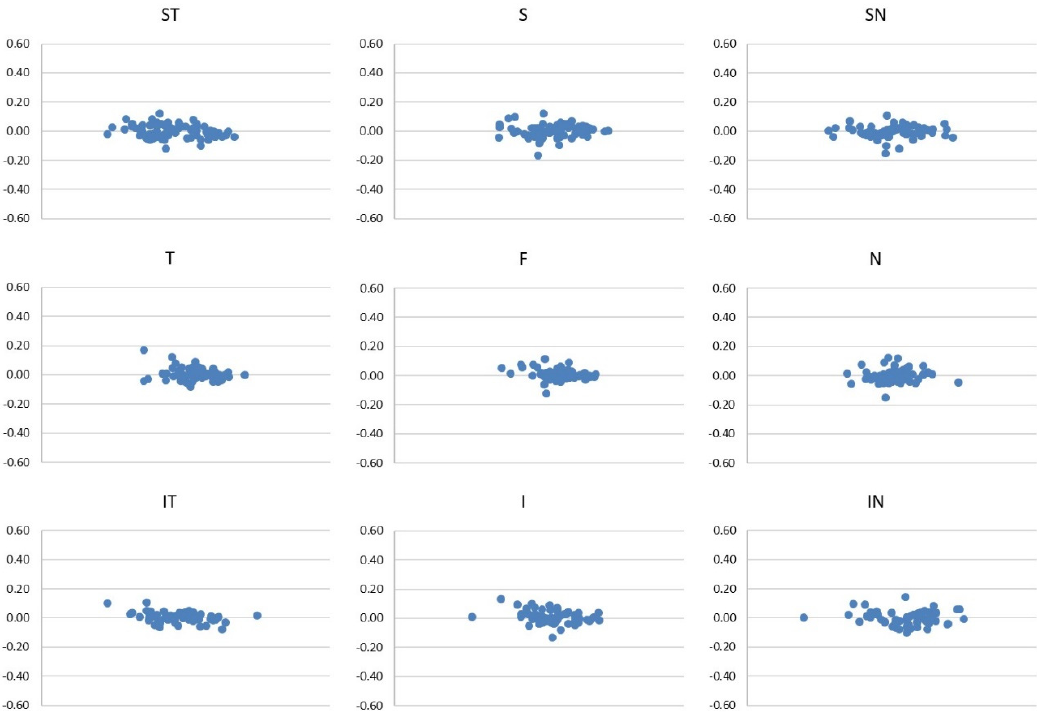
Figure 4. Bland–Altman plots of the first and the second scan of each sector of ICP.